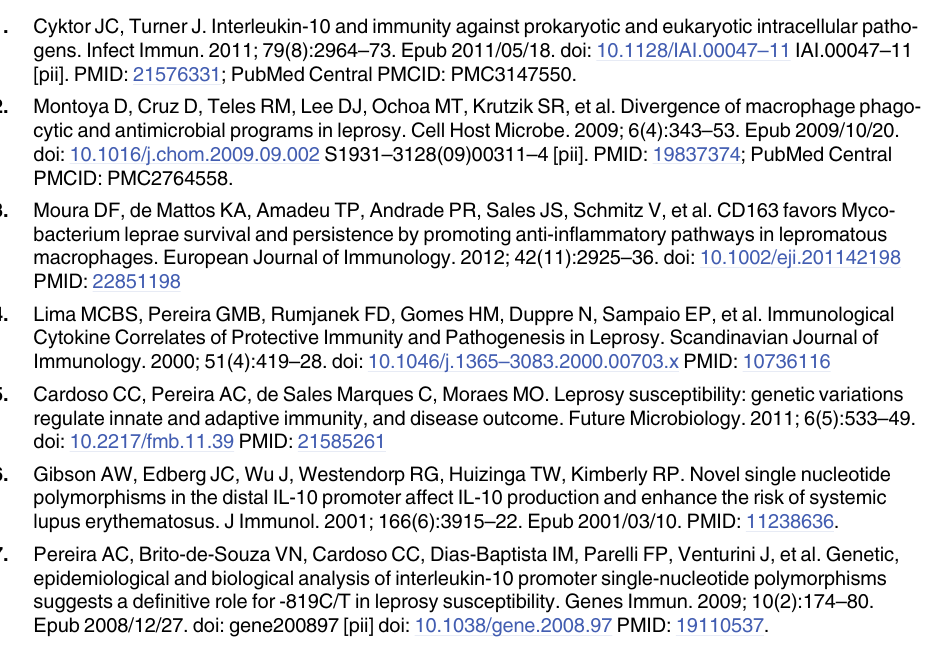
S6 Fig. IL10 – 1082 G > A (rs1800896) and leprosy association. (A) Forest plot summarizing association. Bars represent 95% confidence intervals and boxes represent OR values. (B) Fun- nel plot for publication bias S7 Fig. Linkage disequilibrium analysis for IL10 polymorphisms in populations from 1000 genomes Phase 1. (A) African-AFR. (B) European-EUR. (C) Asian-ASN and (D) Amerin- dian-AMR. Values shown in each box and the intensity of shading are proportional to r 2 . IL10 – 592 C > A (rs1800872) and IL10 – 819 C > T (rs1800871) promoter polymorphisms are shown with (cid:1) . S1 Table. PRISMA Checklist for Meta-analysis on genetic association studies. (PDF) S2 Table. Characteristics of the studies included in the meta-analysis for the IL10 polymor- phisms and